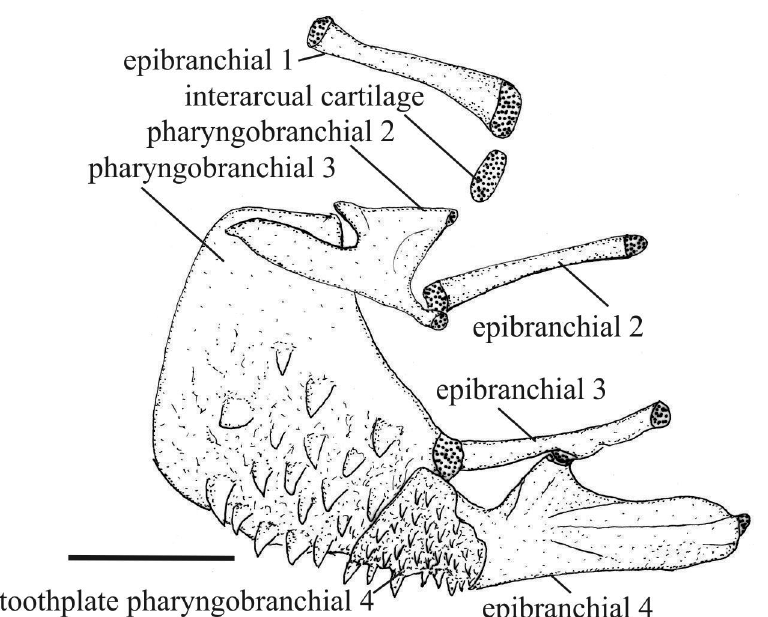
Figure 7. Dorsal branchial arches, left side, ventral view, of Melanorivulus flavipinnis , paratype, UFRJ 6883, 25.6 mm SL. Larger stippling indicates cartilage. Scale bar: 0.5 mm.